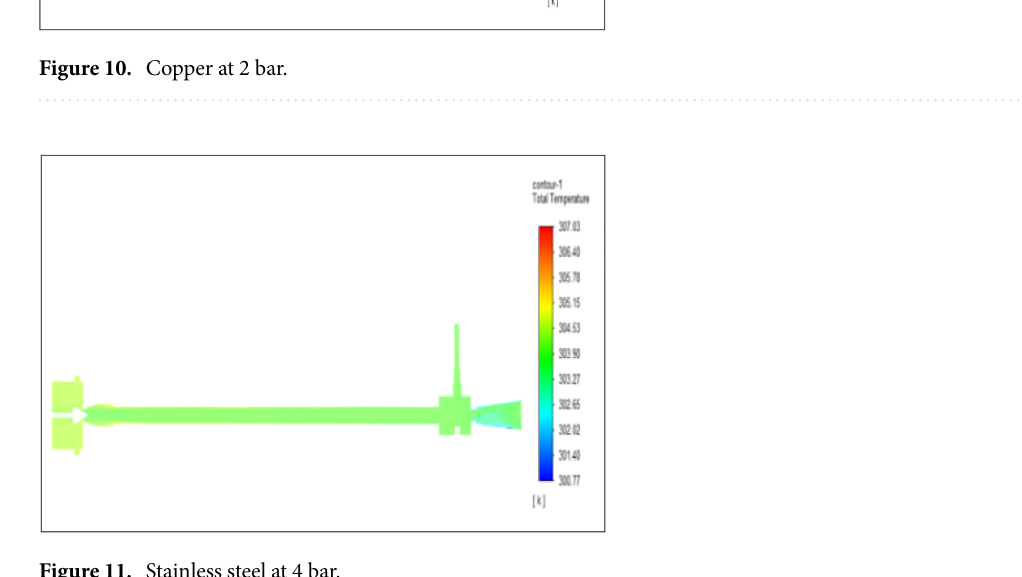
Figure 11. Stainless steel at 4